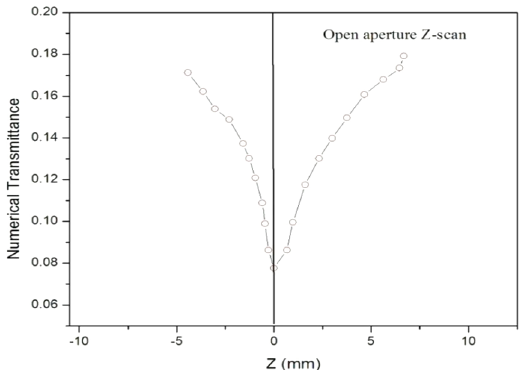
Figure 6. Z-Scan Open aperture.